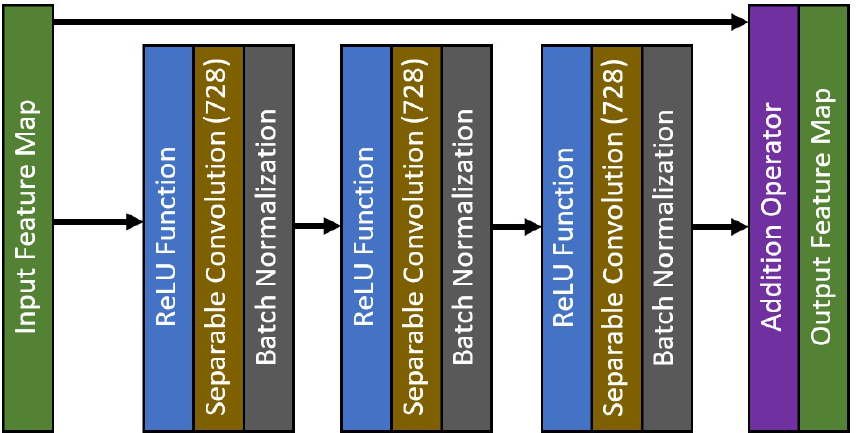
Figure 8. The architecture of a three-layer residual separable convolution network.